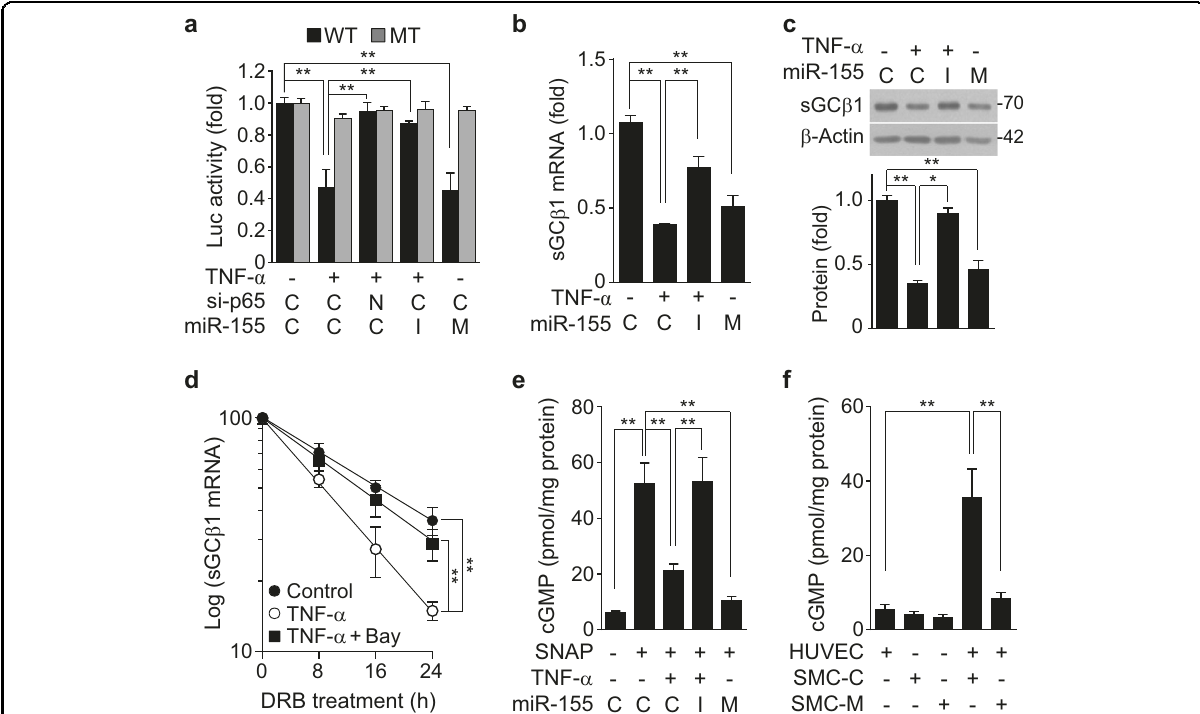
Fig. 4 MiR-155 inhibits sGC β 1 expression by targeting the 3 ′ -UTR of its transcript. a HASMCs were transfected with psiCHECK-2-sGC β 1 3 ′ -UTR- reporter constructs [wild-type or mutant (MT)] or in combination with 80 nM of control siRNA (C), NF- κ B p65 siRNA (N), control miRNA (C), miR-155 mimic (M), or miR-155 inhibitor (I), followed by stimulation with TNF- α for 24 h. Luciferase activity was determined using a dual-luciferase reporter assay kit ( n = 3). b , c Transfected HASMCs were stimulated with TNF- α for 24 h. The sGC β 1 mRNA and protein levels were determined by qRT-PCR and Western blotting ( n = 3). d Cells were stimulated with or without TNF- α in the presence or absence of Bay11-7082 (Bay, 5 μ M) for 12 h, followed by treatment with 5,6-dichloro-1- β -D-ribofuranosylbenzimidazole (40 μ g/mL) for the indicated time periods. The sGC β 1 mRNA levels were determined ( n = 3). e Transfected HASMCs were stimulated with TNF- α for 24 h, followed by further incubation with SNAP (100 μ M) for 24 h. The cGMP levels were determined using a cGMP assay kit ( n = 6). f HASMCs were transfected with control miRNA (SMC-C) or miR-155 mimic (SMC-M), followed by co-culture with HUVECs for 24 h. The cGMP levels were determined using an ELISA kit ( n = 4). * P < 0.05 and ** P < TNF- α (Fig. 5f). Similar phenomena were also observed for the migration of HASMCs treated with a combination of DETA/NO, TNF- α , a miR-155 mimic, and a miR-155 inhi- bitor (Fig. 5g and Supplementary Figure 7). Collectively, these data suggest that miR-155 promotes VSMC phenotypic switching from the contractile to the synthetic state by inhibiting the NO/sGC/cGMP pathway under in fl ammatory conditions.